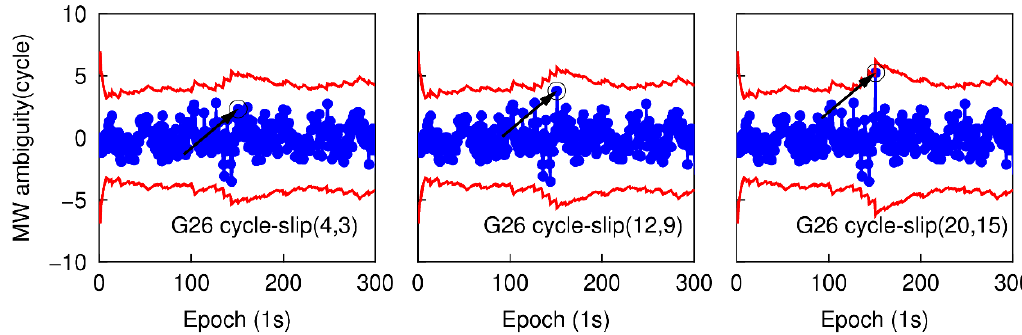
Figure 9. Specific small cycle-slip combination detection results with MW combination for G26.